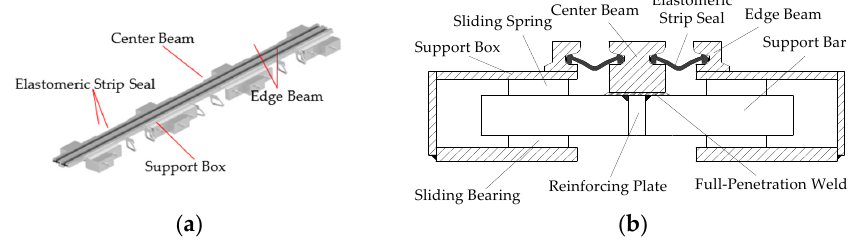
Figure 1. The MBEJ. ( a ) Three-dimensional view. ( b ) Main components.